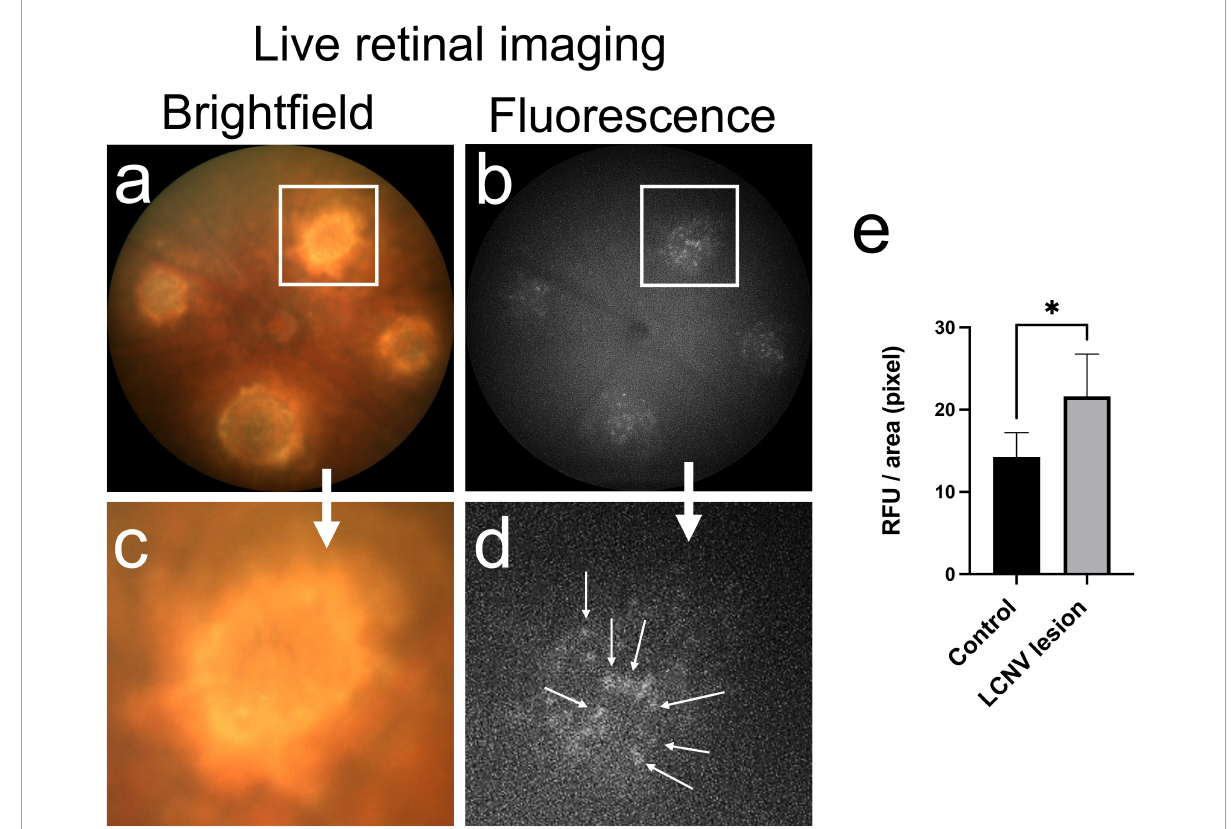
FIGURE4 In vivo retinal imaging of NLRP3 in laser-induced choroidal neovascularization (LCNV) using InflammaProbe-1. (a) Brightfield and (b) fluorescence fundus images of mouse LCNV taken 6 h after a 10 mg/kg intraperitoneal injection of InflammaProbe-1 on day 4 post-LCNV. The fluorescence fundus image shows InflammaProbe-1-dependent fluorescence that is localized to each of the LCNV lesions observed in the brightfield fundus image. These are representative images of 12 mouse LCNV eyes. (c,d) Higher magnification of panels (a,b) , respectively. (e) Fluorescence intensity measurements expressed in relative fluorescence units (RFU) per pixel area were measured using ImageJ software. Statistically significant fluorescence enhancement was observed in LCNV lesions compared to those in the non-laser control groups. Statistical significance * p <